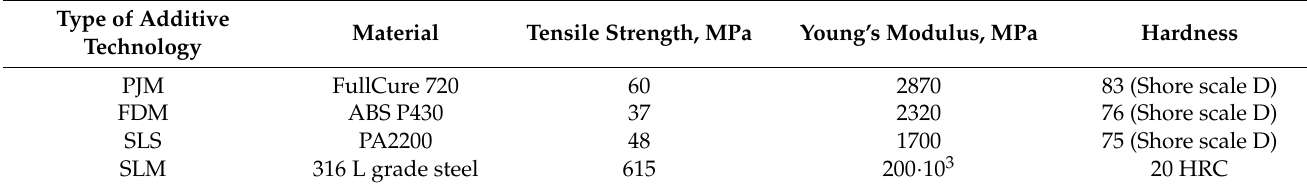
Figure 2. The 3D printers used to 3D print the samples. ( a ) Connex 350, ( b ) 3D Dimension 1200es, ( c ) Formiga P100, ( d ) Concept laser M2. Table 1. Selected mechanical properties of the materials used to print the samples